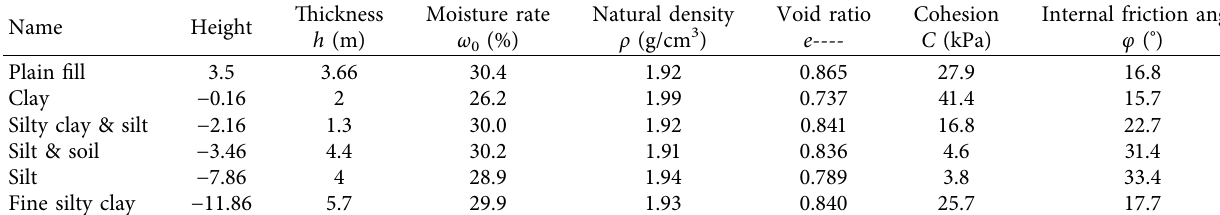
Table 2: Physical mechanics parameters of soil